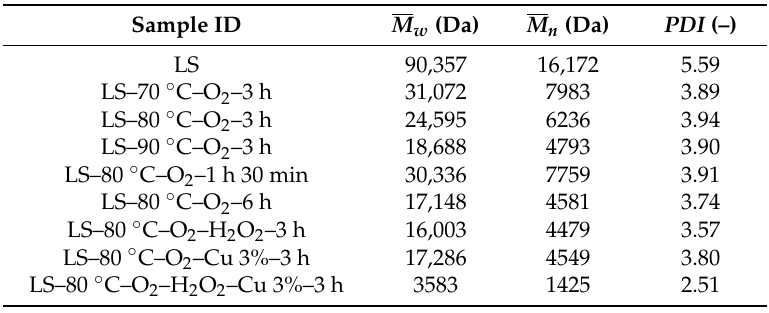
Table 1. Average molecular weights and PDI for the initial and depolymerized